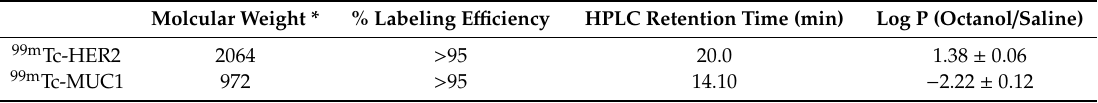
Table 1. Characterization of 99m Tc-HER2 and 99m Tc-MUC1